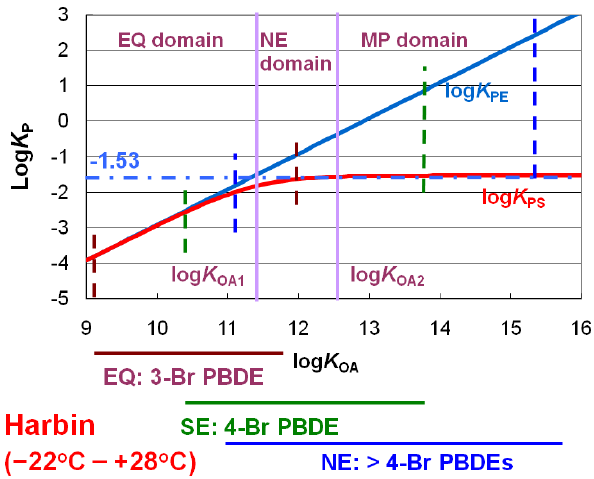
Figure 4. The log K P –log K OA diagram for the 10 PBDE congeners in Harbin air at a temperature range of − 22 to + 28 ◦ C. The EQ group includes BDE-17 and -28, the SE group contains BDE-47 and -66, and the rest belong to NE group. The range of log K OA for each group and their corresponding log K P –log K OA diagram are also shown. The log K P –log K OA diagram for the EQ group, indi- cated by two burgundy dashed lines, is mainly in the EQ domain, with a small portion in NE domain; the log K P –log K OA diagram for the SE group, contained by two green dashed lines, is mainly in the NE domain, with a small portion in MP domain; and the log K P – log K OA diagram for the NE group, formed by the two blue dashed lines, is mainly in the NE and MP